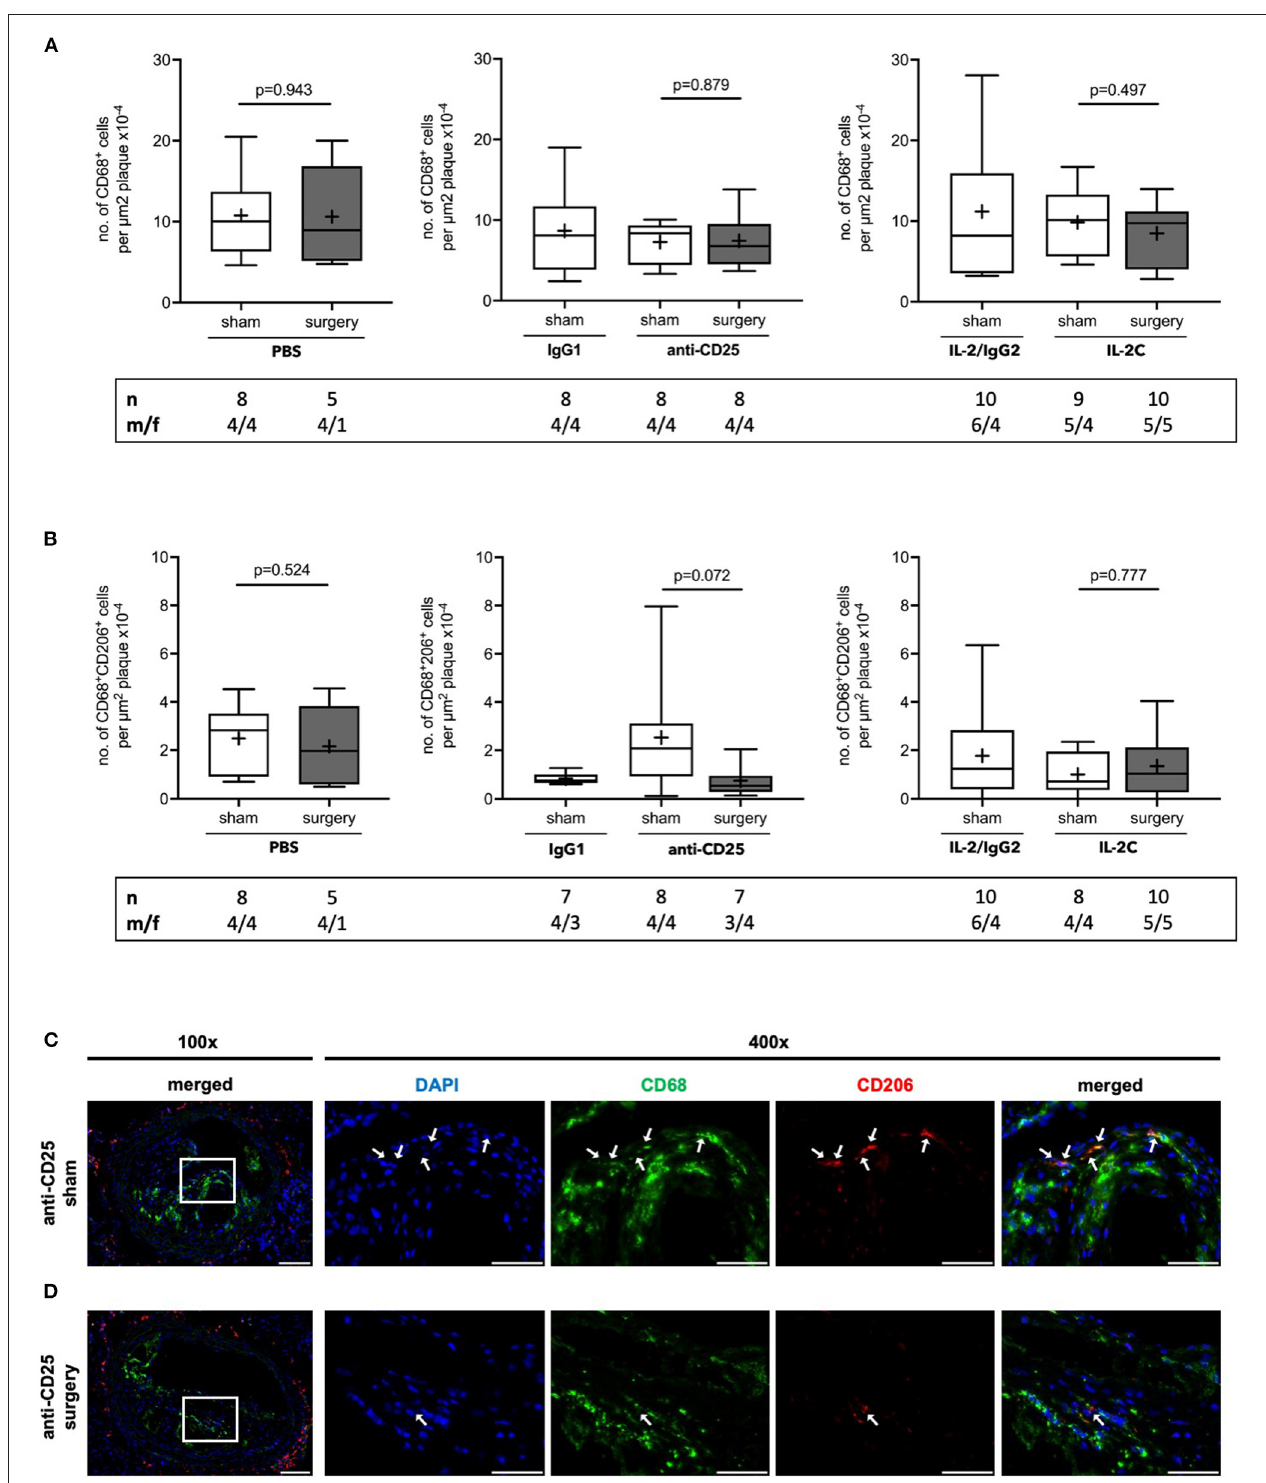
FIGURE 5 | Quantification of atherosclerotic plaque macrophages in ApoE − / − mice with modulated Treg levels and subjected to surgery or sham intervention. Immunofluorescent staining of (A) CD68 + total macrophages and (B) alternatively activated M2 subtype CD68 + CD206 + macrophages per plaque area in cross-sections of brachiocephalic arteries at the site of maximum stenosis. (C) Representative micrographs of CD206 stainings in mice treated with anti-CD25 mAb